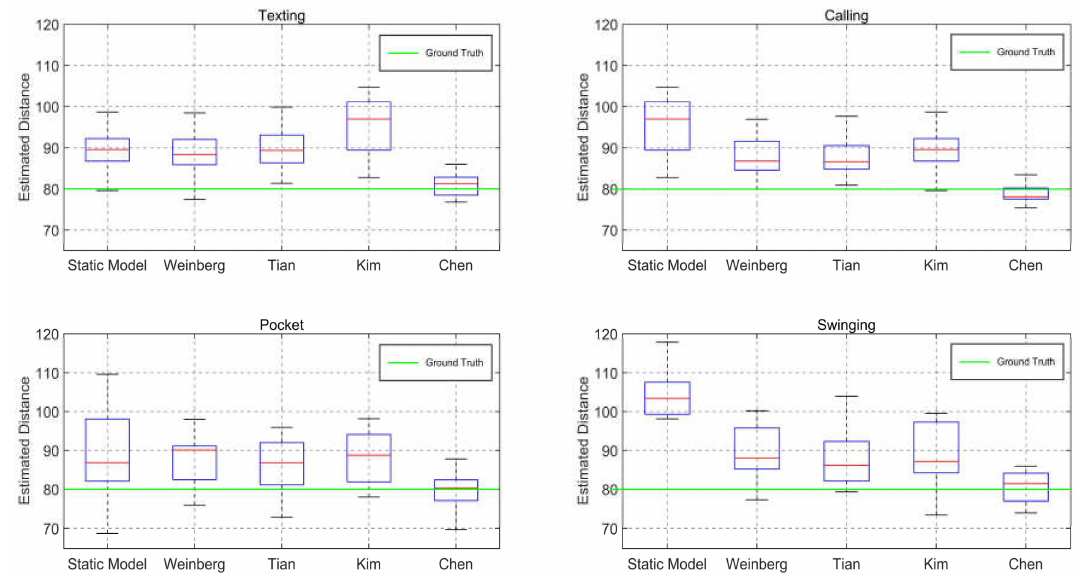
Figure 10. Comparison of the walking distance estimation method in different